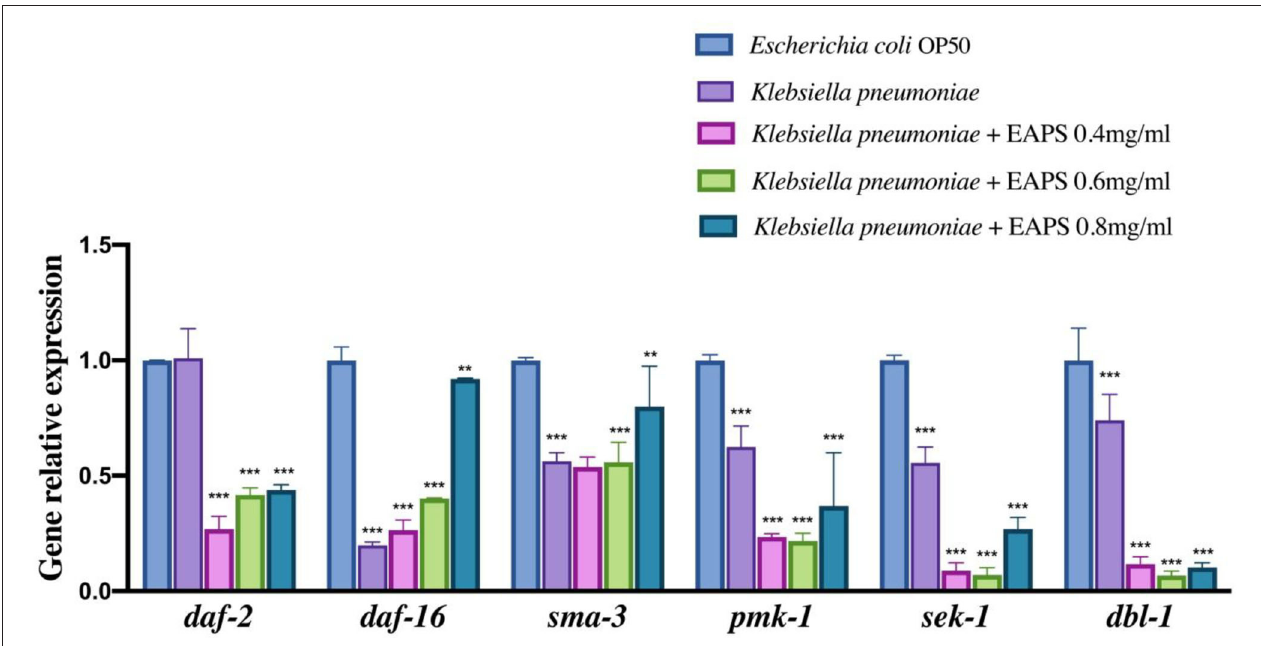
FIGURE 8 | Relative expression of immunity and longevity-related genes in infected nematodes treated with EAPS. All tests were performed in triplicate and repeated at least once, and the results were expressed by their means ± SD. Statistical significance of the treatment effects was determined by Duncan’s multiple range t -test (** p < 0.01 and *** p <